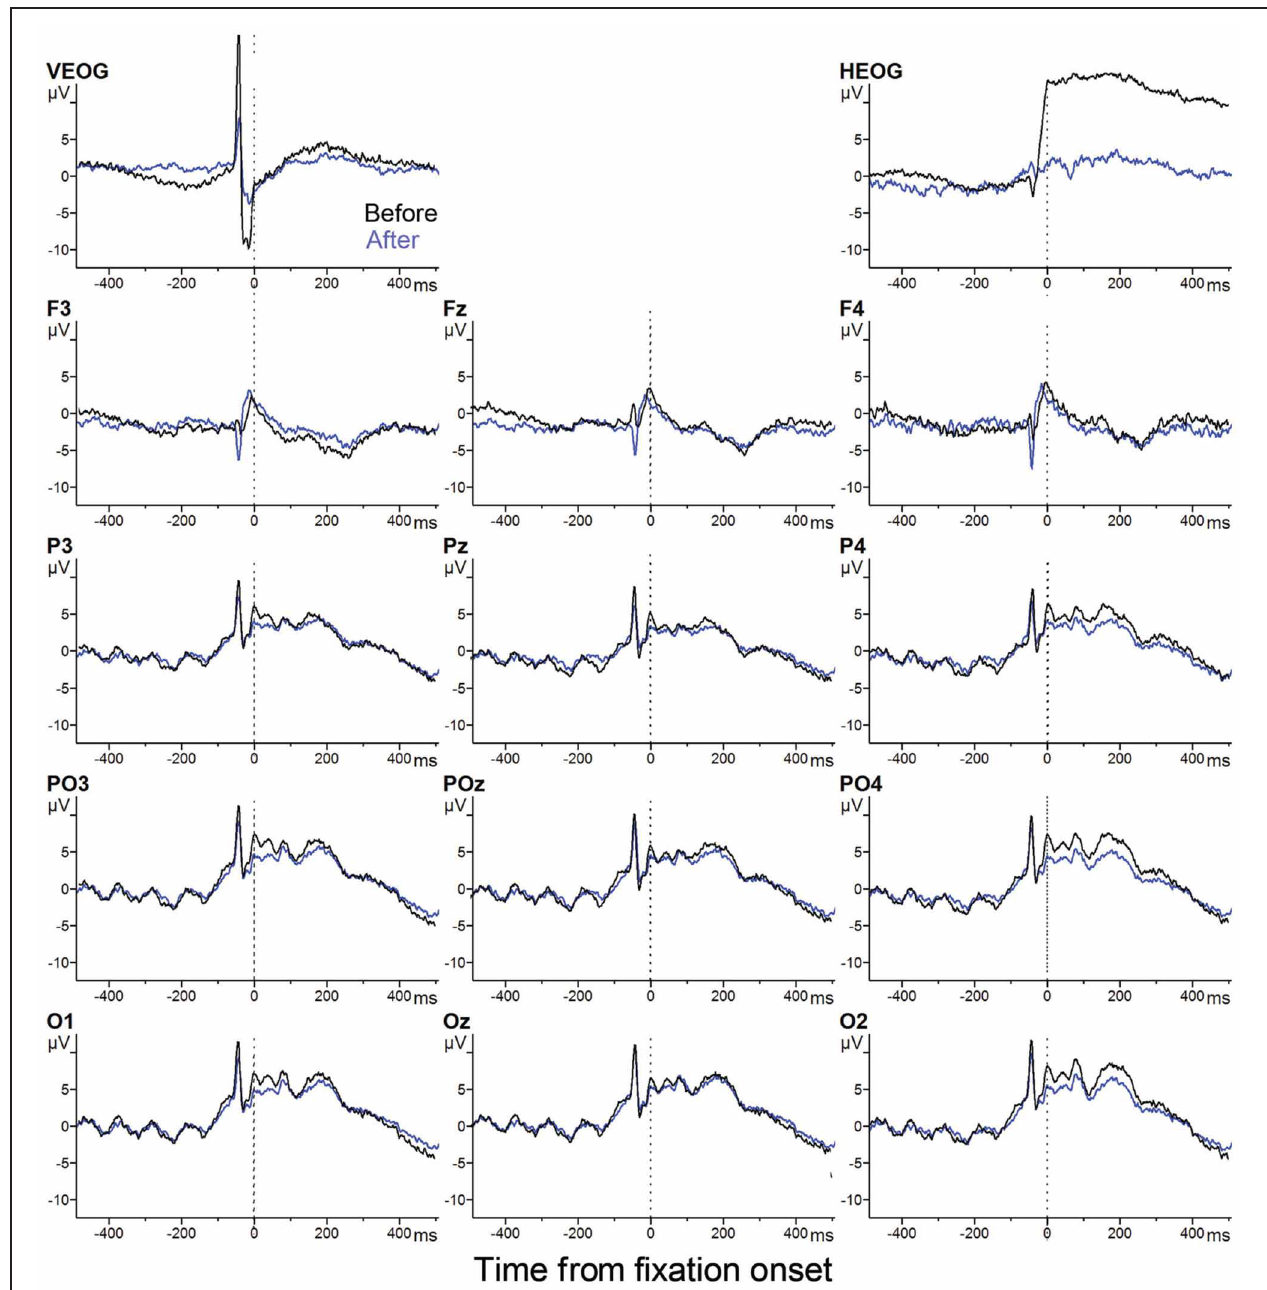
FIGURE A1 | EFRP before and after EOG artifact